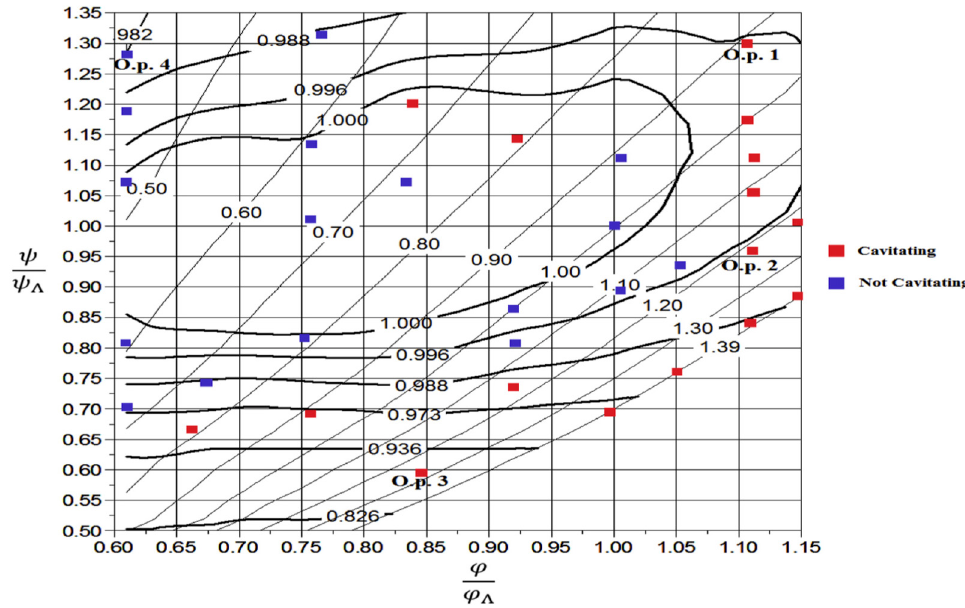
Figure 16. Hill chart for showing cavitation and non-cavitation operating points [43].